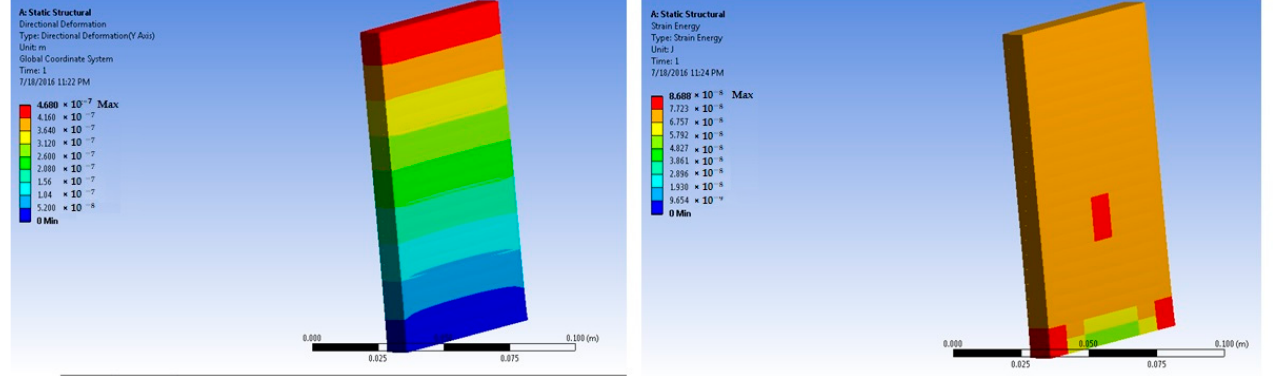
5 N force (deformation and